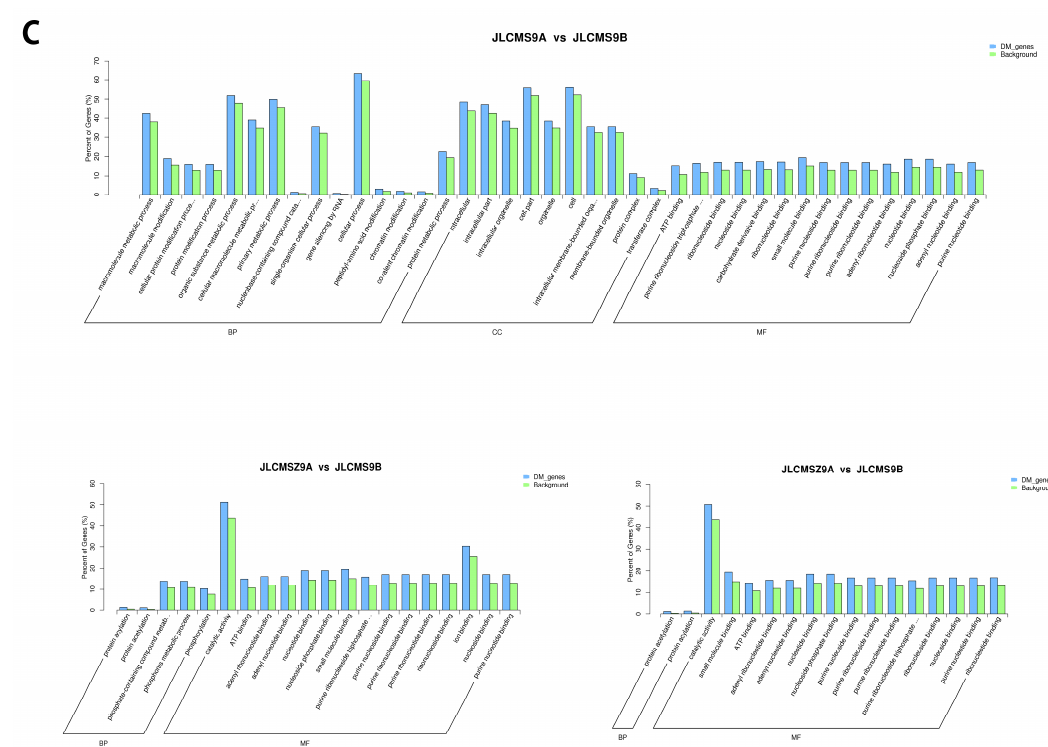
Figure 4. Gene ontology (GO) functional enrichment analysis in three sequence contexts of differential methylation regions (DMRs) in the whole soybean genome. Letter ( a , b , c ) represents sequence contexts mCG/CG, mCHG/CHG, and mCHH/CHH, respectively. BP: biological process; CC: cellular component; MF: molecular function.